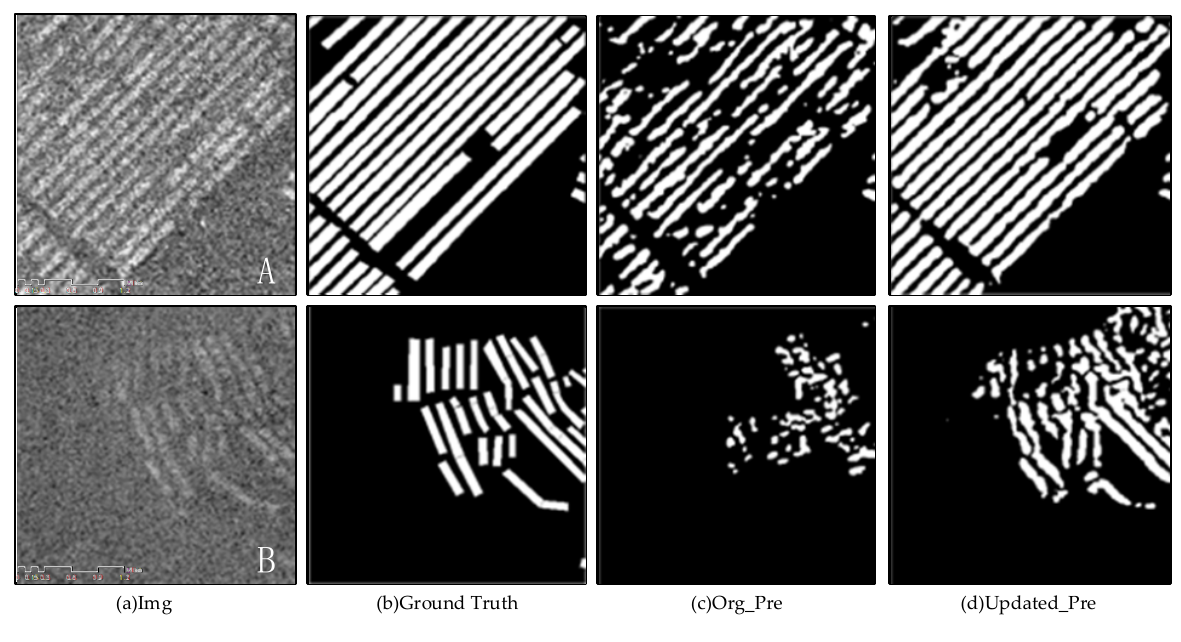
Figure 5. Extraction results for regions A and B before and after sample expansion. ( a ) Test image; ( b ) Ground truth; ( c ) The extraction result after training of the initial sample; ( d ) The extraction result after expansion of the sample.